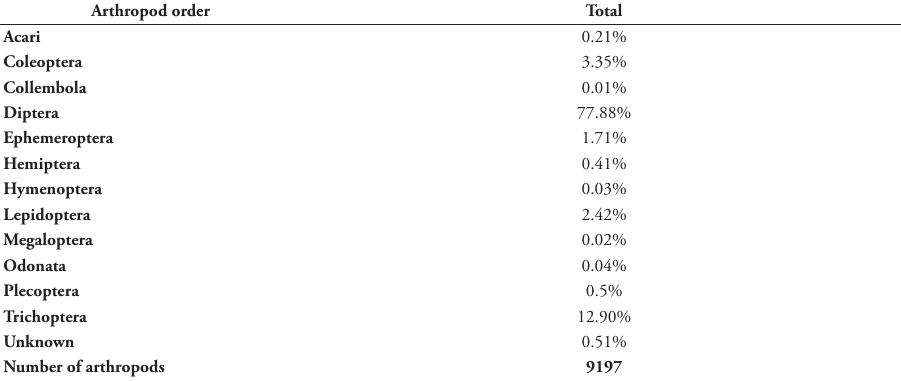
Table 2. Proportion of arthropods found in all samples by insect order with total number of arthropod individuals counted.